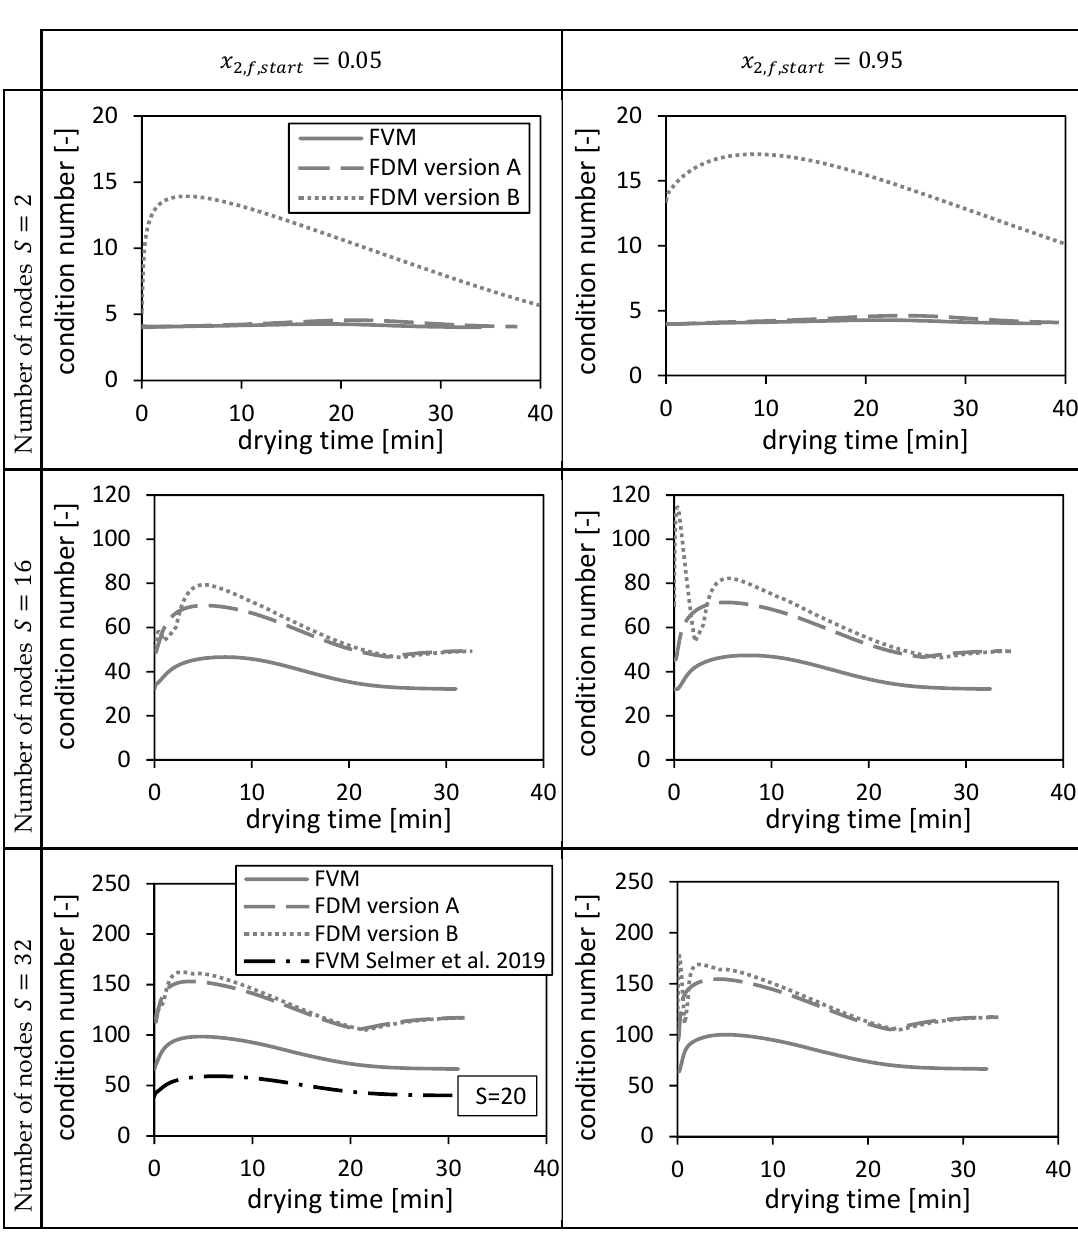
Figure 10. Condition numbers of 𝐴 (cid:3004)(cid:3007)(cid:3020) (cid:3038) and 𝐴 (cid:3007)(cid:3005)(cid:3014)(cid:3038) (version A and B) corresponding to the FVM, FDM version A and B and the FVM, with the settings used in Selmer et al. 2019 [3], using x (cid:2870),(cid:2916)(cid:2929)(cid:2930)(cid:2911)(cid:2928)(cid:2930) = 0.05 (left panels) and x (cid:2870),(cid:2916)(cid:2929)(cid:2930)(cid:2911)(cid:2928)(cid:2930) = 0.95 (right panels) depending on the drying time and the number of nodes S. Calculation settings: N = 26, S REF = 64, Δ t = 0.05 s (for FVM, FDM version A and B), Δ t = 0.1 s (for FVM Selmer et al. 2019 [3]), S = 20 (for FVM Selmer et al. 2019 [3]).